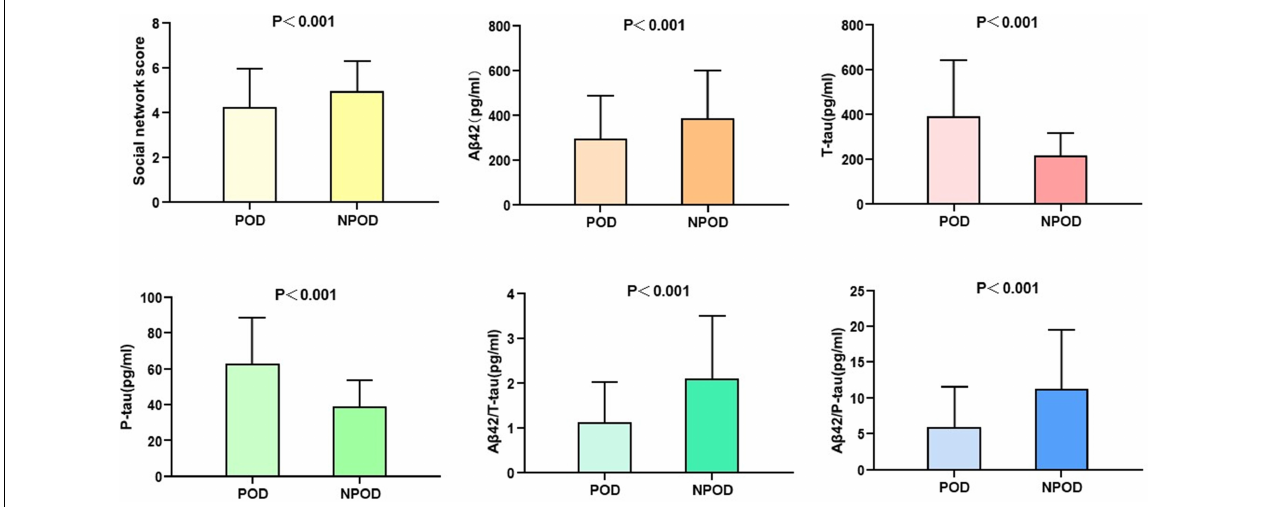
FIGURE 2 | Social network score and expression of biomarkers in CSF of POD patients and NPOD controls.